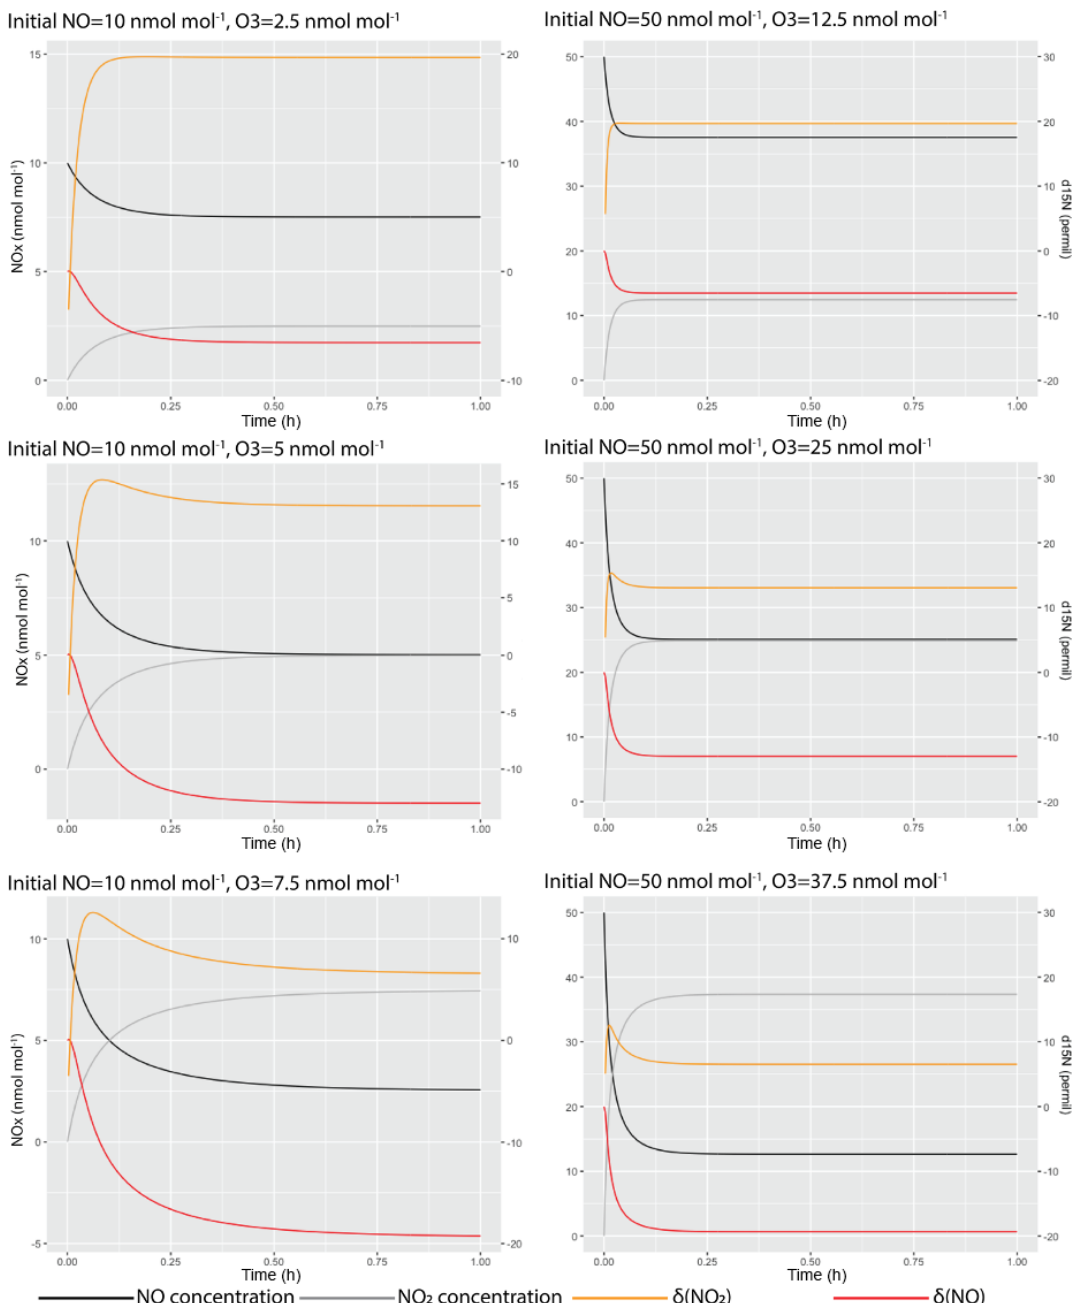
Figure B1. Simulated NO–NO 2 isotopic equilibrium process in the chamber at various NO and O 3 concentrations.